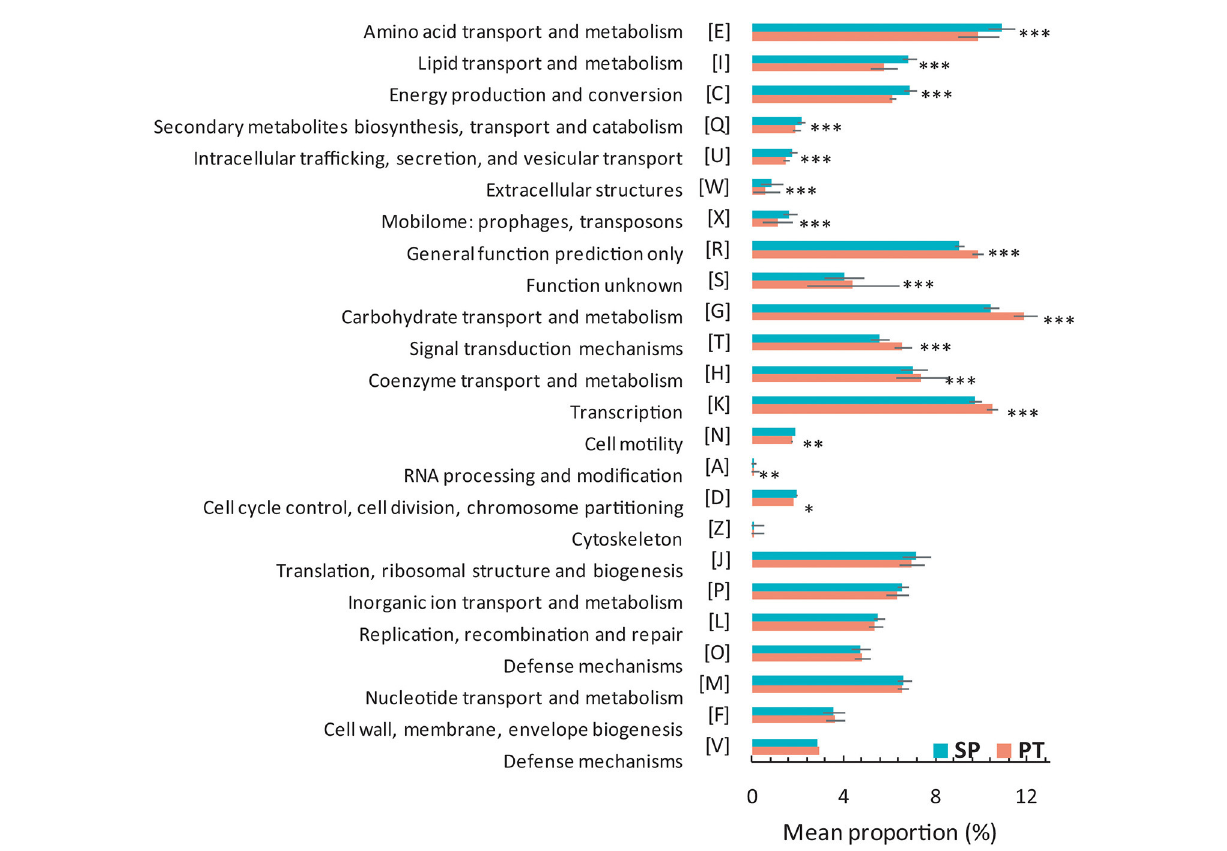
FIGURE2 Proportional differences of COG category between the SP and PT groups. Two groups were defined by the strains with T max ≤ 20 ◦ C (SP) and T max > 20 ◦ C (PT). P -values were obtained using the Student’s t- test. *** P < 0.005; ** P = 0.005–0.01; * P = 0.01–0.05.